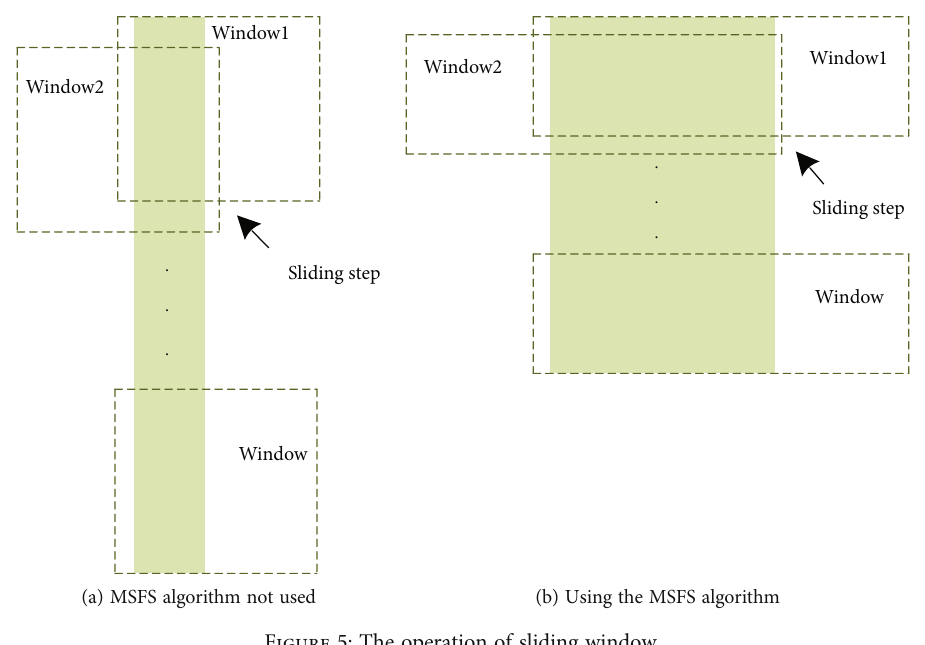
Figure 5: The operation of sliding